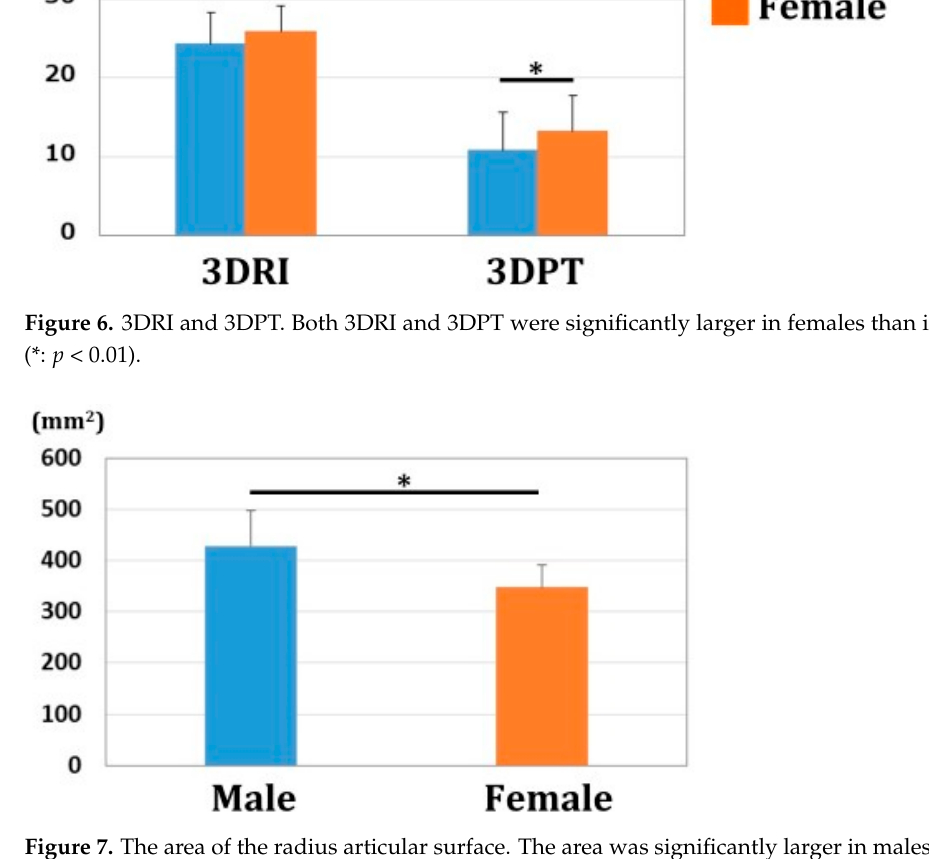
Figure 7. The area of the radius articular surface. The area was significantly larger in males than in females (*: p <